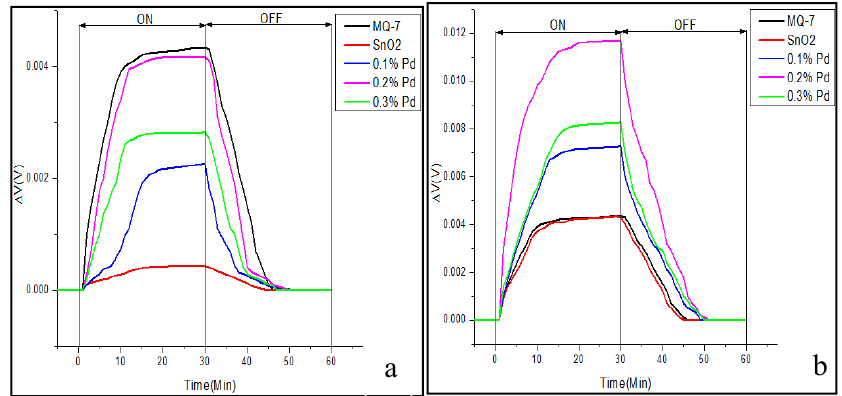
Figure 8. Comparison of change in voltage for pure SnO 2 as well as with different concentrations 0.1%, 0.2%, 0.3% of palladium and commercial CO sensor MQ-7, tested for 60 min @1000 rpm, connected as ( a ) three sensor array and ( b ) eight sensor array.